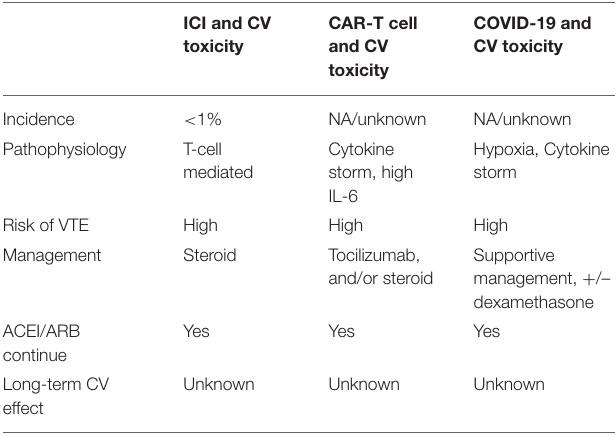
TABLE 2 | Clinical characteristics of similar CV toxicity in ICI therapy, CAR T-cell therapy, and COVID-19. ICI and CV